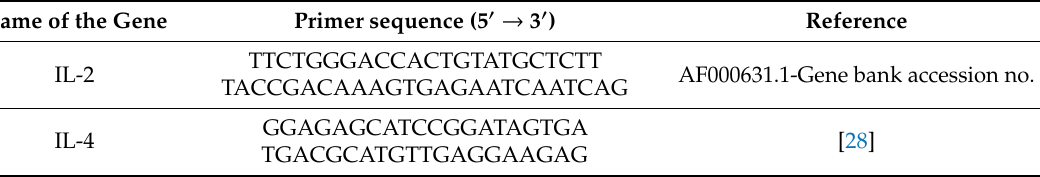
Table 1. Details of the oligonucleotide primer sequence used for chicken specific genes in qReal-time PCR. Name of the Gene Primer sequence (5 (cid:48) → 3 (cid:48) ) Reference IL-2